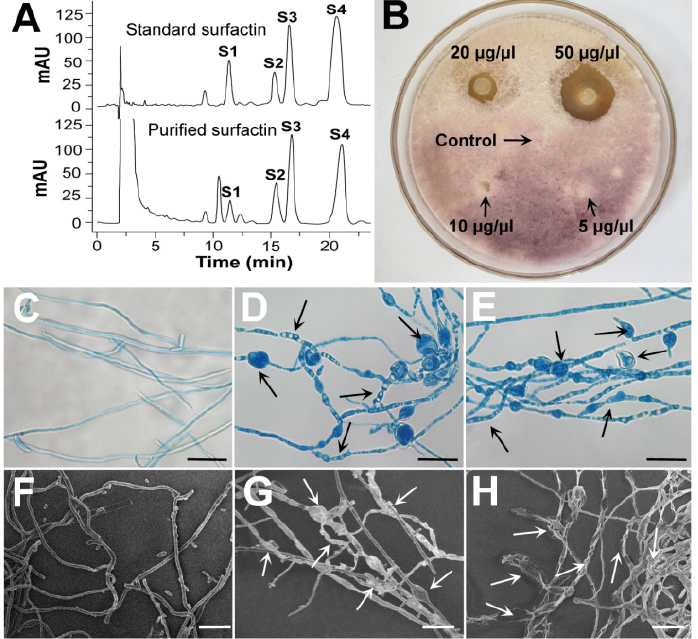
Figure 5. The HPLC fingerprint spectrum of surfactin produced by B. subtilis SF1 and its effects on the mycelium growth and morphology of F. foetens . ( A ) HPLC analysis of standard surfactin and the purified surfactin from B. subtilis SF1. ( B ) The antifungal activity of surfactin against F. feotens in vitro. ( C , F ) F. foetens mycelium without surfactin treatment under positive fluorescent microscopy and SEM. ( D , E ) Surfactin-treated F. foetens mycelium under positive fluorescent microscopy. ( G , H ) Surfactin-treated F. foetens mycelium under SEM.